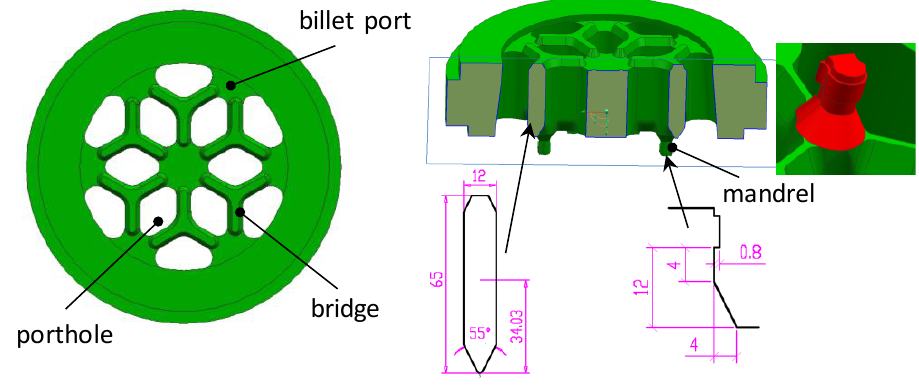
Figure 2. The main structures of upper die.